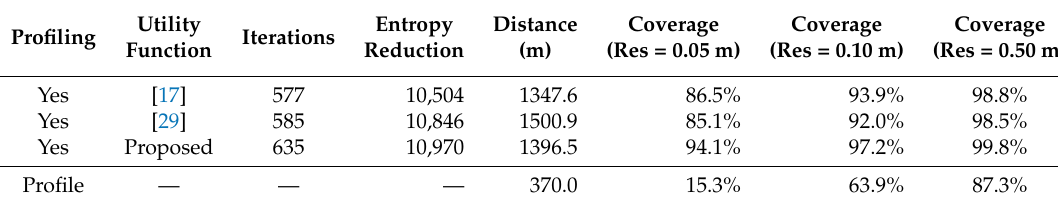
Figure 8. The path followed by the UAV in simulation around the aircraft model using three different utility functions: ( a ) our proposed utility; ( b ) Isler et al. [29] utility; and ( c ) Bircher et al. [17] utility. Table 2. Scenario 1 (aircraft) final results showing coverage completeness by using the proposed utility function compared to the other